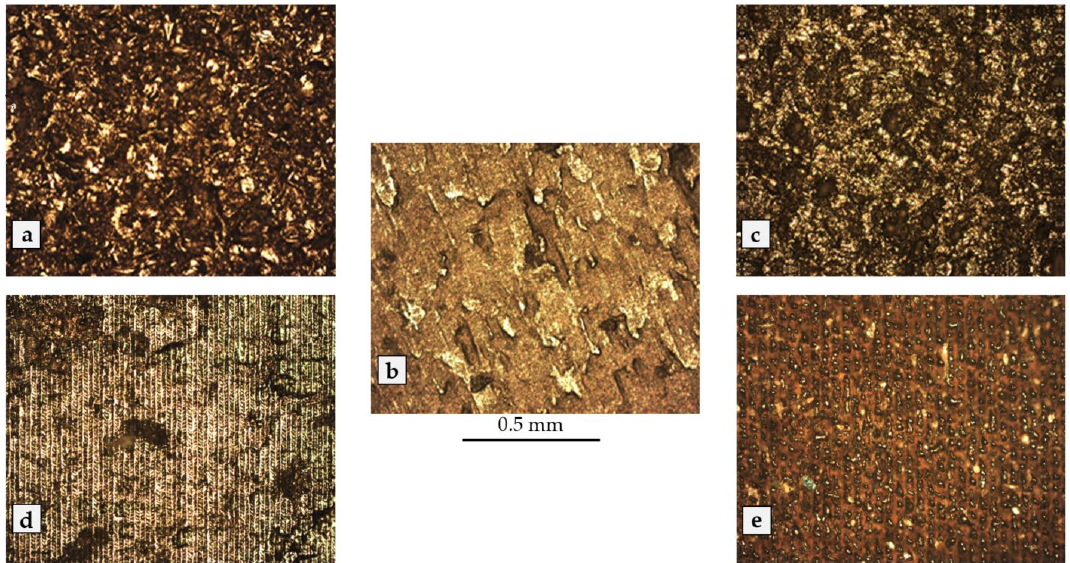
Figure 2. Metallography at 10x of the surfaces obtained for: ( a ) Shot blasting (Corundum particles); ( b ) Non-textured; ( c ) AWJT; ( d ) Laser Power 5 W; ( e ) Laser Power 20 W.